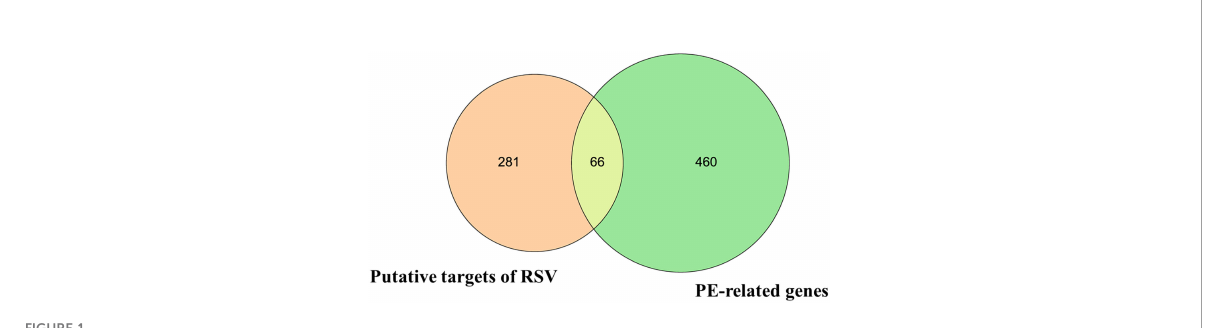
FIGURE 1 The Venn diagram. The orange circle represents the putative targets of RSV. The green circle represents the PE-related genes. The yellow overlapping part represents the 66 intersecting targets. RSV, resveratrol; PE, preeclampsia.